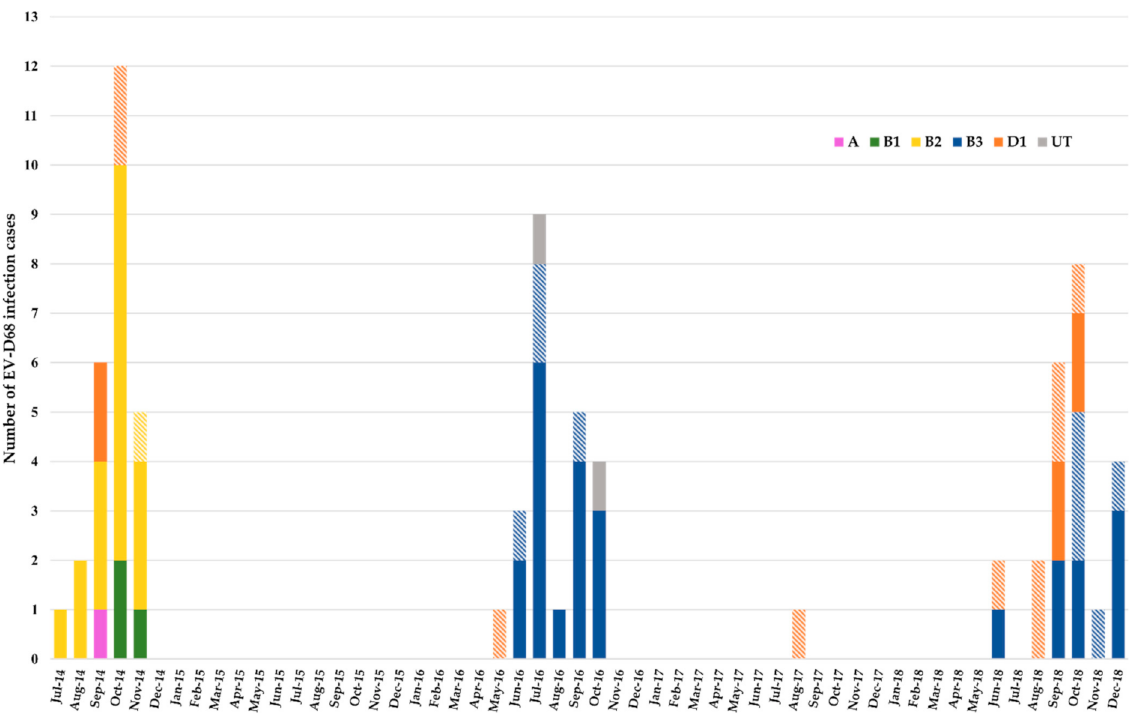
Figure 1. Monthly distribution of EV-D68 infections, Clermont-Ferrand, 2014–2018. Histogram colours match the EV-D68 clade related to the infection case as indicated on the graph. Hatched colours match EV-D68 in adult patients. Solid colours match EV-D68 in paediatric patients. UT: